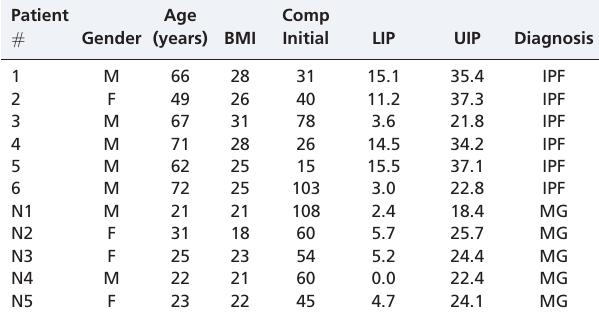
Table 3 - Results of the comparison between patients with IPF and controls.